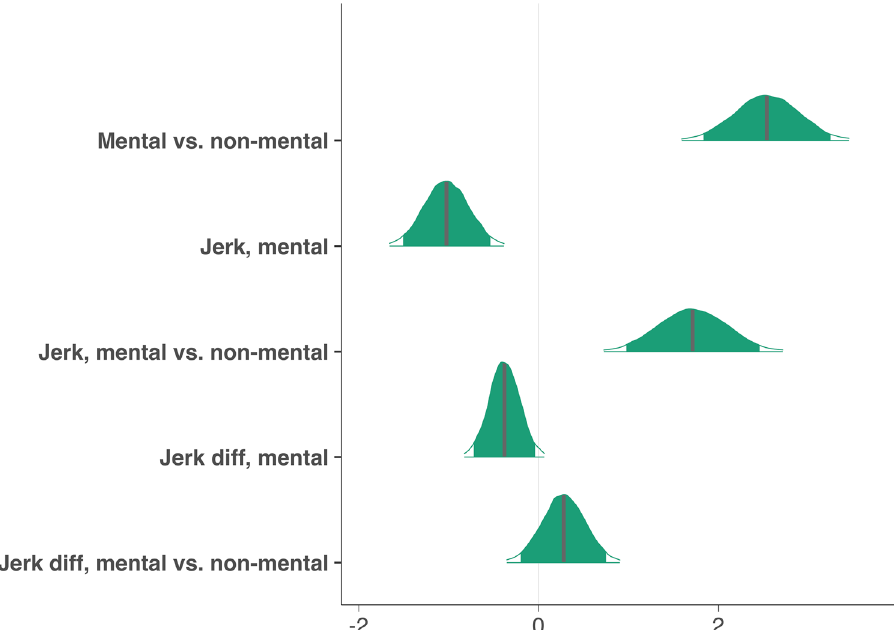
Figure 2. Posterior probabilities of model parameters predicting accuracy. Filled green areas represent 95% credible Intervals around parameter estimates. Grey lines represent means of parameter estimates. ‘Jerk diff’ = jerk